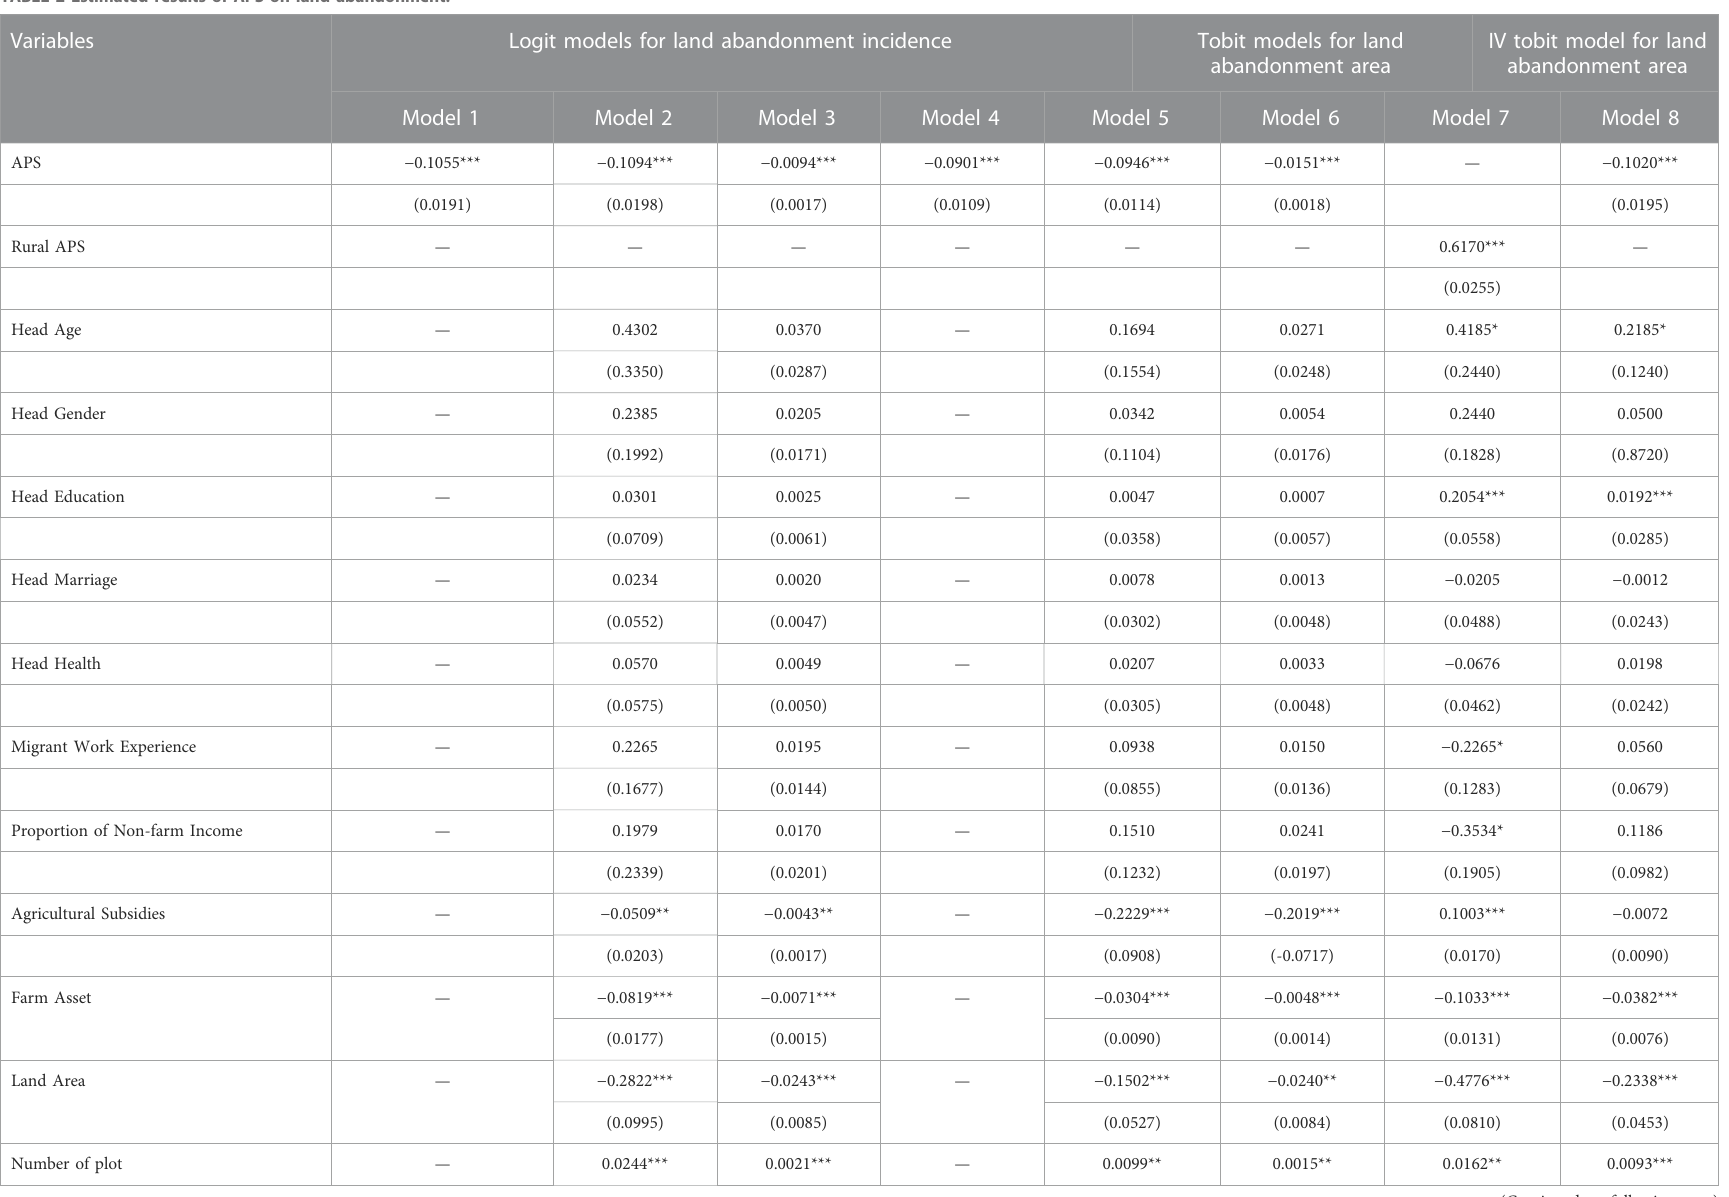
TABLE 2 Estimated results of APS on land